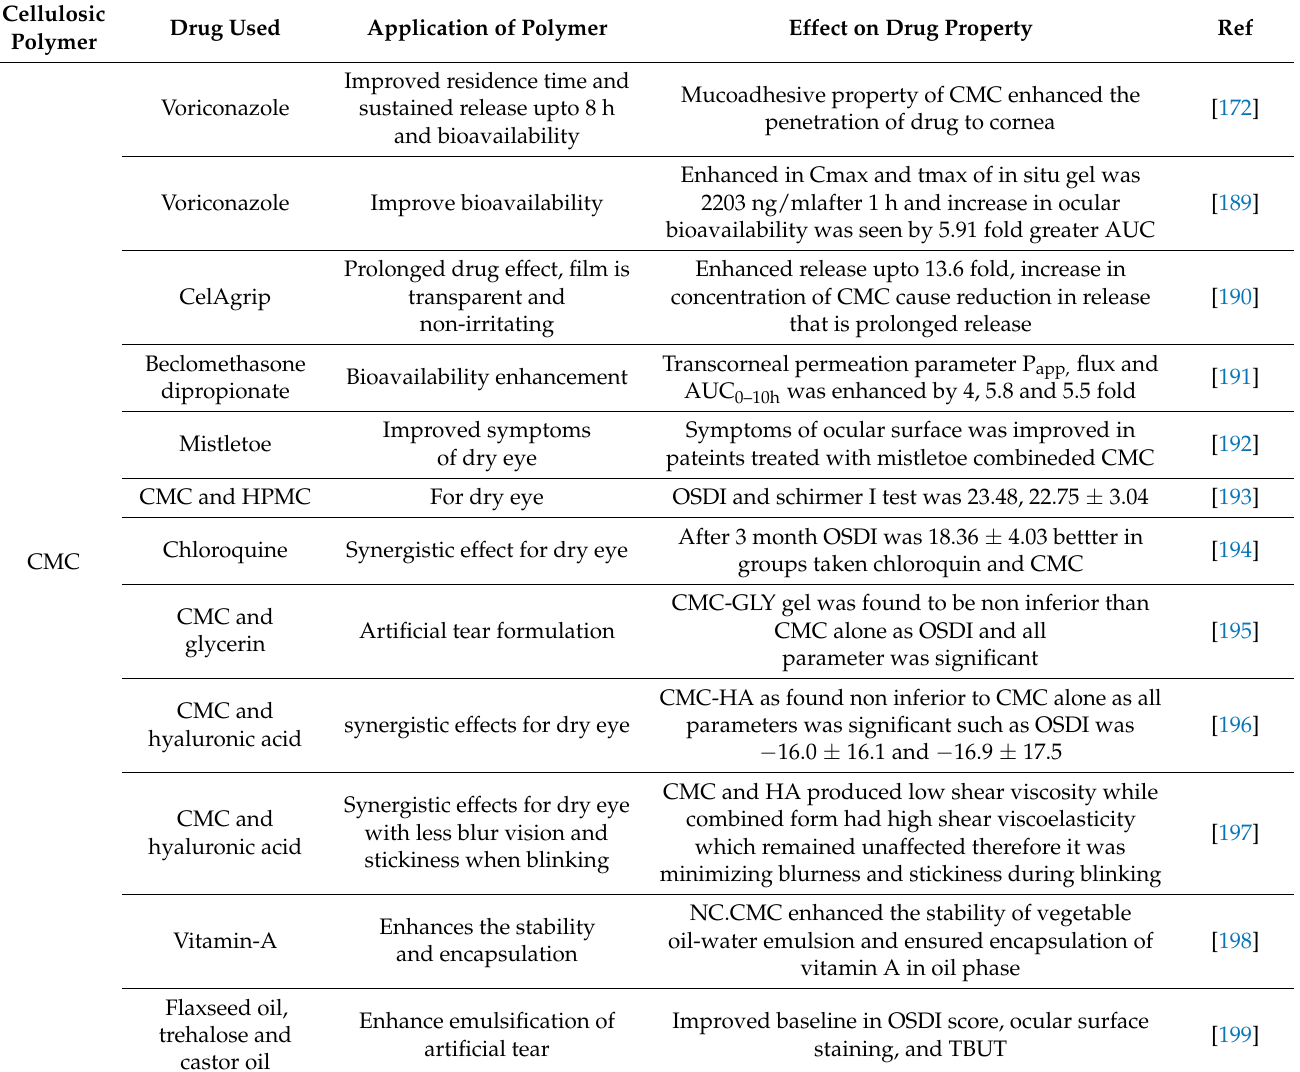
Table 7. Application of CMC in ocular drug